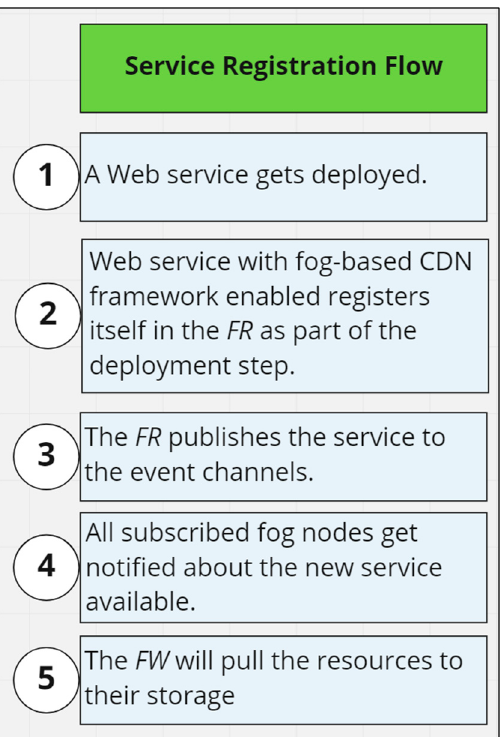
Figure 6. The web service registration steps.